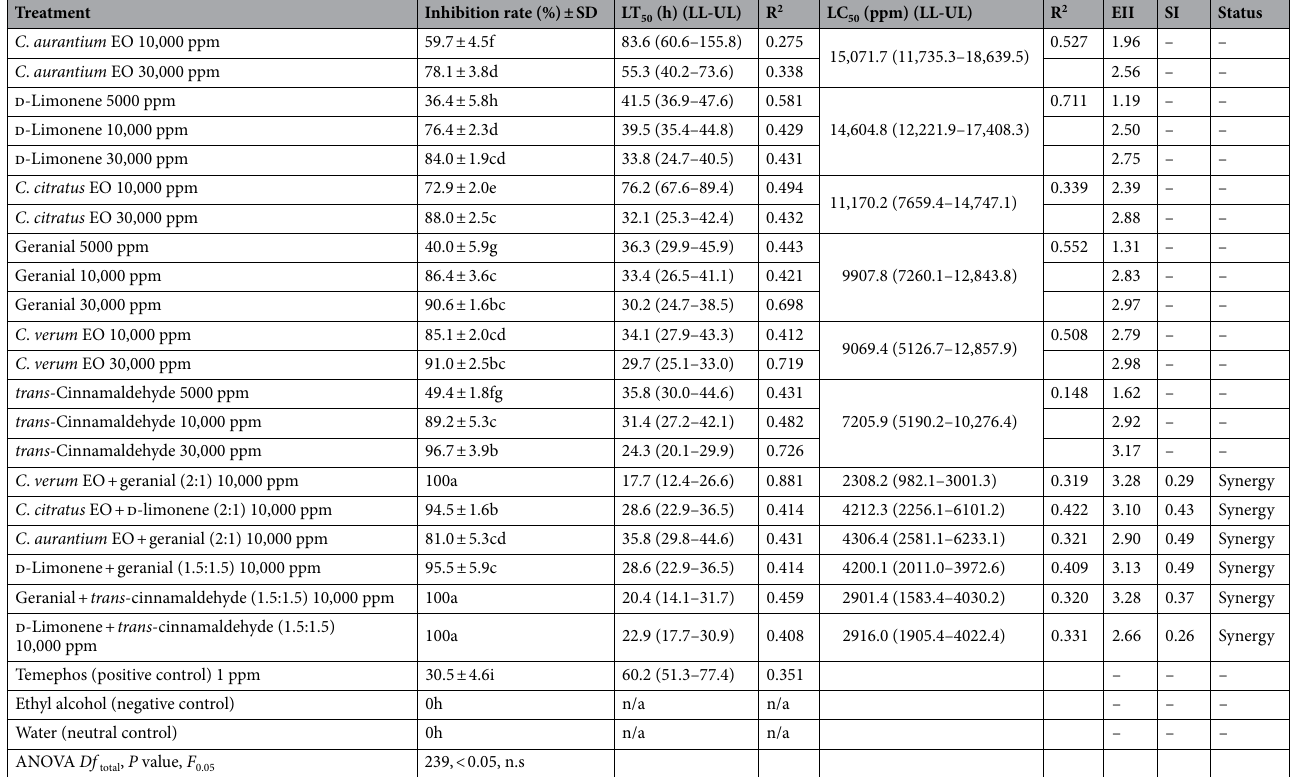
Table 2. Ovicidal effects of EO formulations from Cinnamomum verum , Citrus aurantium , and Cymbopogon citratus EOs and their major constituents and combined formulations on the hatching rate of Aedes aegypti eggs after 48 h of incubation. Means percentage ovicidal activities in each column followed by same letters are not significantly different by ANOVA at P < 0.05. LT 50 Lethal time that kills 50% of the exposed eggs, LC 50 Lethal concentration that kills 50% of the exposed organisms, LL , 95% lower confidence limit and UL , 95% upper confidence limit, R 2 regression coefficient, EII effective inhibition rate index, n.s. not significantly different at P < 0.05, SI Synergistic index, n/a not